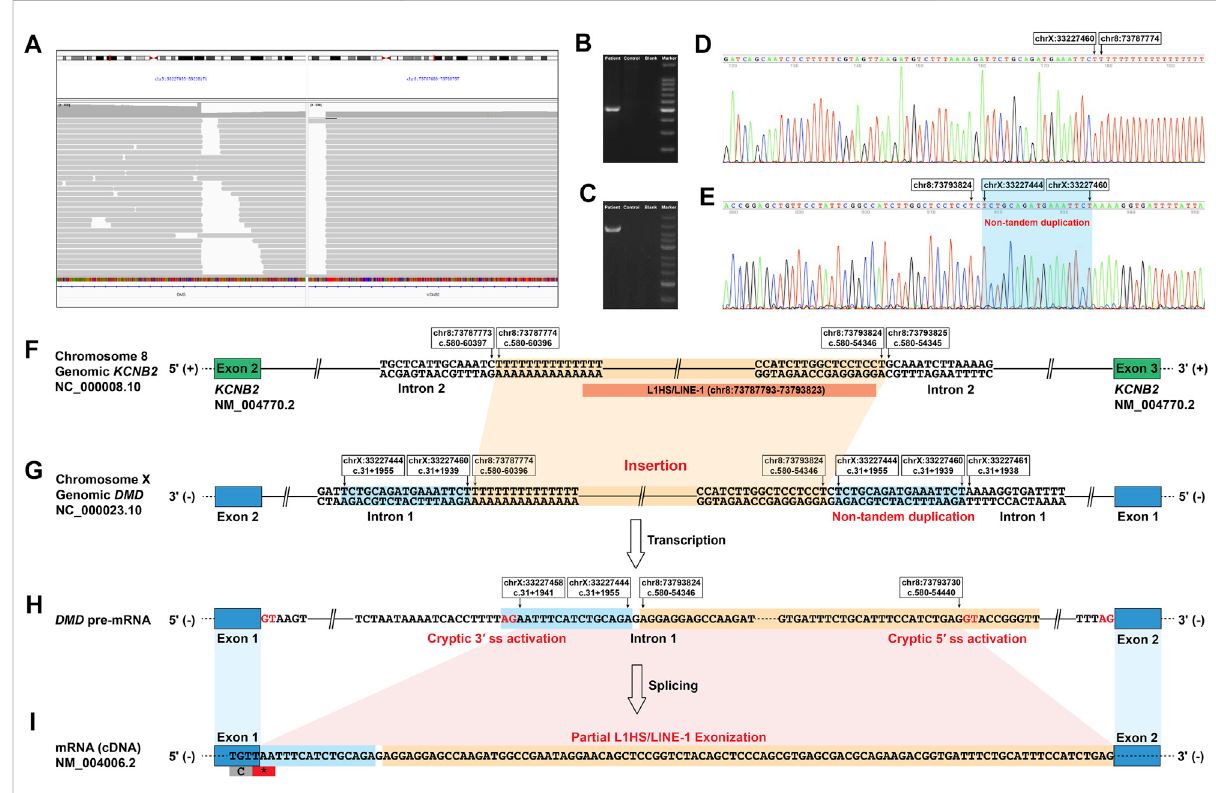
FIGURE 2 Identi fi cation of a novel deep intronic structural variant in DMD and its aberrant splicing effect on DMD pre-mRNA. (A) The IGV screenshot of long-readwhole DMD genesequencingofthepatientindicatedaninsertionofa~6-kbsequencefromchromosome8inthedeepintronicregionof DMD intron 1. Successful PCR ampli fi cation of the genomic 3 ′ (B) and 5 ′ (C) breakpoint regions using primers designed for the deep intronic DMD variant detected by the long-read whole DMD gene sequencing. Successful Sanger sequencing of the genomic 3 ′ (D) and 5 ′ (E) breakpoint regions con fi rmedthe exact sequences of thebreakpoint regions. (F – I) Schematic diagram of the abnormal DMD splicing event caused by thedeep intronic structural variant in the patient. (F) and (G) The structural variant located in the deep intronic region of DMD intron 1, insertion of a 6,051-bp sequenceoriginatingfromadeepintronicregionin KCNB2 intron2 fl ankedbyanon-tandemduplicationofa17-bpsequenceoriginatingfrom DMD intron 1. Most of the inserted sequence was annotated as an L1HS element belonging to the LINE-1 family. (H) The structural variant activated a cryptic5 ′ ssintheLINE-1elementandacryptic3 ′ ssinthedeepintronicregionof DMD intron1. (I) Thecryptic5 ′ ssand3 ′ ssactivationresultedinthe 111-bpsequenceinsertion between DMD exons 1and2, consisting ofa15-bpsequenceof DMD intron1,asingleguaninenucleotide,and